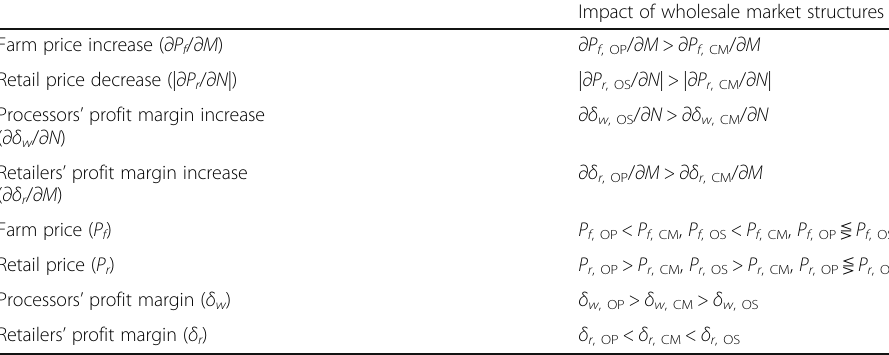
Table 1 The impact of various wholesale market structures on farm and retail price and processors ’ and retailers ’ profit